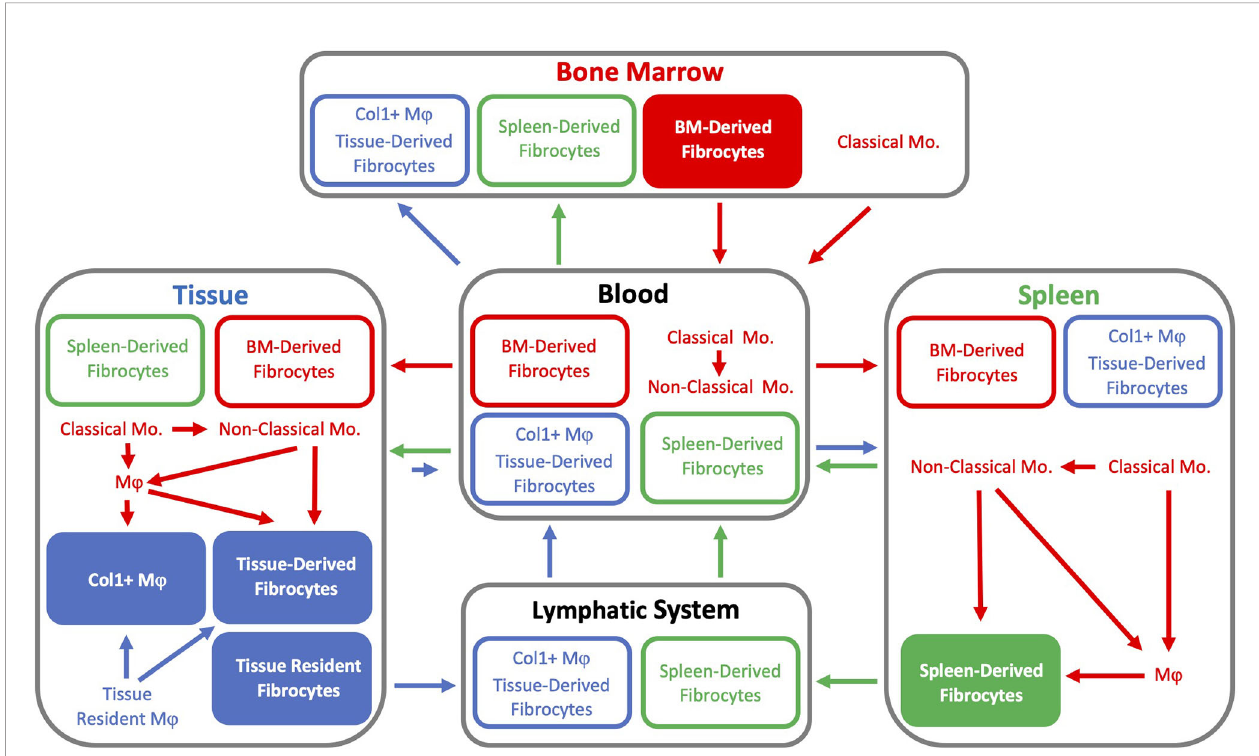
FIGURE 2 | Potential origins and traf fi cking of fi brocytes. This diagram shows potential fi brocyte precursors and sites of differentiation. In addition, it shows the traf fi cking of fi brocytes as well as Col1+ macrophages that do not express collagen that could account for the identi fi cation of Col1+ hematopoietic-derived cells within the bone marrow, blood, spleen, and in peripheral tissues. Fibrocytes may differentiate from a dedicated precursor within the bone marrow before being released into the circulation. Alternatively, fi brocytes may instead differentiate from monocytes or macrophages. Classical monocytes are continuously generated by hematopoiesis in the bone marrow and are released into the circulation. Most monocytes leave the circulation to enter a particular tissue as classical monocytes, but some are retained and differentiate into non-classical monocytes. While limited evidence suggests that classical monocytes do not directly differentiate into fi brocytes, non-classical monocytes, monocyte-derived macrophages, and tissue resident macrophages may be possible fi brocyte precursors. In addition, like tissue resident macrophages there may also exist a tissue resident population of fi brocytes established early in development. Both fi brocytes and Col1+ macrophages may reenter the circulation through the lymphatic system allowing them to traf fi c to the spleen or bone marrow. Differentiation of monocytes and macrophages into fi brocytes may also occur in the spleen and/or splenic fi brocytes may have extra-splenic origins. Potential origins of fi brocytes in the bone marrow (red), tissue (blue), and spleen (green) are identi fi ed by the solid-colored bubbles. The arrows are color-coded to identify the directional traf fi cking of each population and the potential for each cell population to be present outside of their anatomical compartment of origin is indicated by bubbles outlined in the color according to the location of origin. For example, spleen-derived fi brocytes may reenter the circulation directly or indirectly through the lymphatic system. Once in the circulation, spleen-derived fi brocytes may then traf fi c to the bone marrow or another tissue. bone marrow (BM), Col1 immunolabeled (Col1+), monocyte (Mo.), macrophage (M j ), peripheral blood mononuclear cells